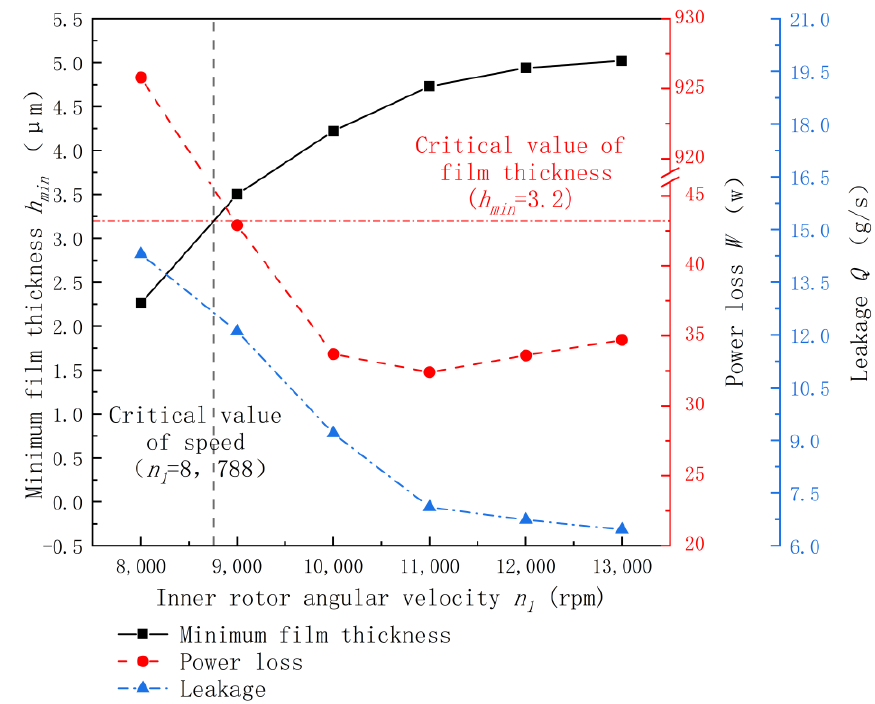
Figure 10. Inner rotor speed effects on sealing performance.